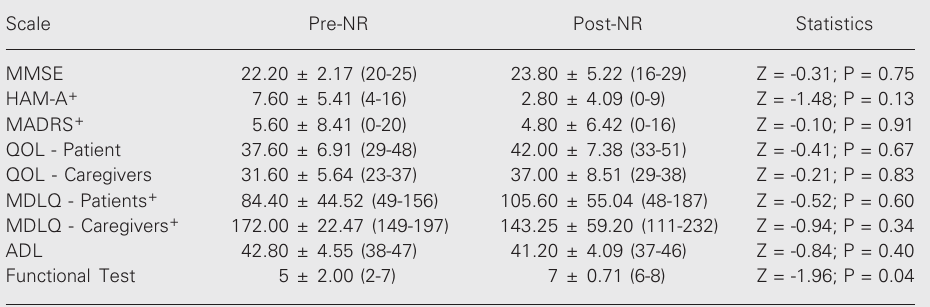
Table 2. Results of the scales applied to patients and caregivers pre- and post-neuropsychological rehabilita- tion